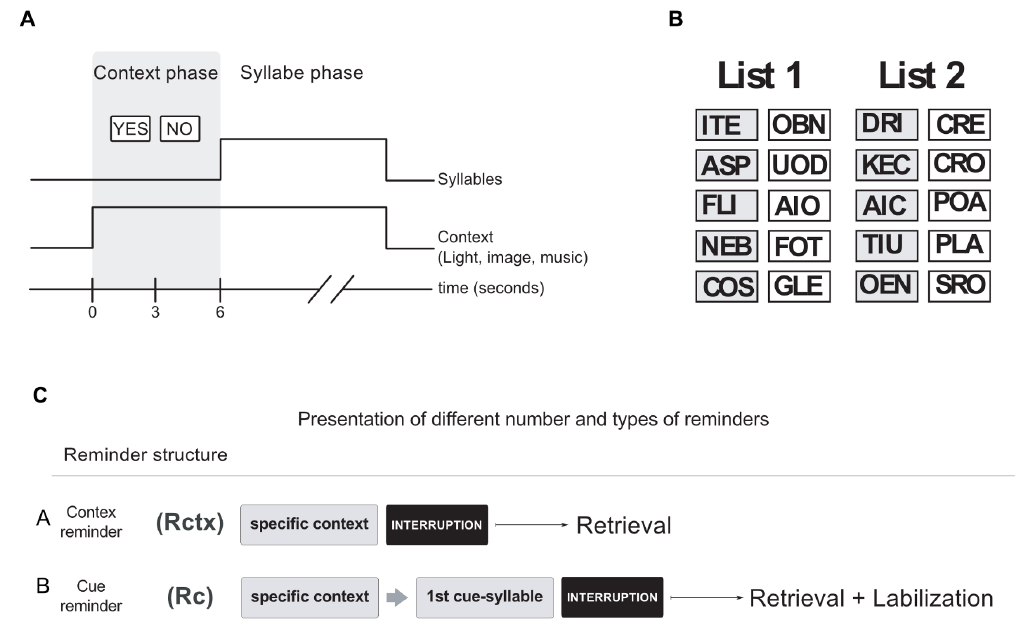
Figure 4. Experimental Protocol. A) Actual trial. It was formed by the context period: specific combination of a light (color illumination of the room), image (a picture on the monitor) and sound (music melody from earphones); and by a syllable period: six seconds after the stimuli presentation, five pairs of cue-response syllables were presented successively and in random order. B) Paired-associated memory. The List1 and List2 list presented in the training and testing sessions. C) Types of reminders. ( Top diagram ) The cue reminder (Rc) included the specific context, subjects had to press the expectancy keys (YES-NO), then one cue-syllable was presented after which the trial was abruptly interrupted, thus not allowing the subject to answer with the respective response-syllable. ( Middle diagram ) The context reminder (Rctx) consisted of the presentation of specific context, subjects had to press the expectancy keys (YES-NO) and the trial was abruptly interrupted before any syllable presentation. ( Bottom diagram ). Scissors stand for the full-stop of each type of